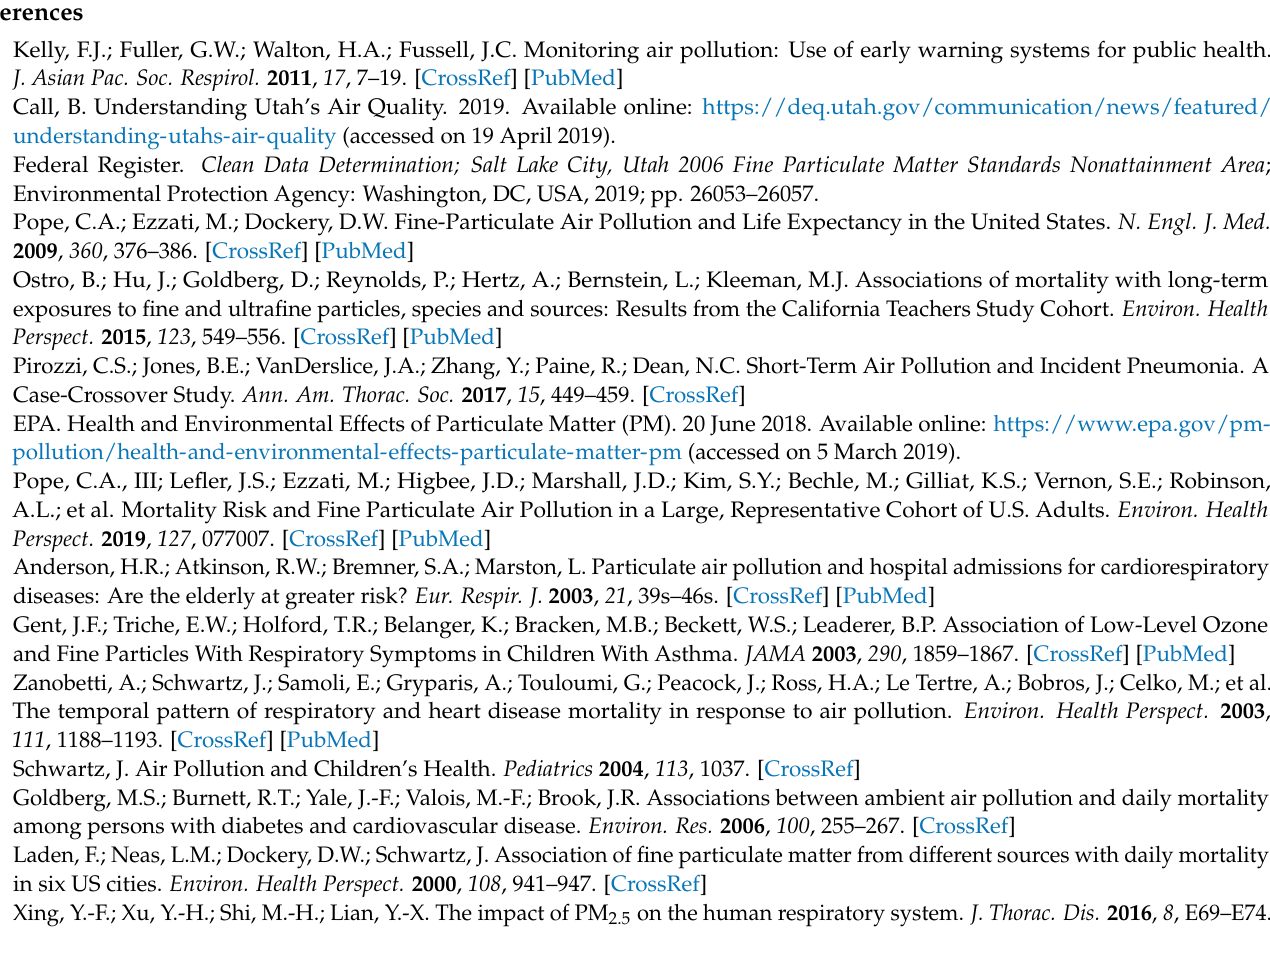
(in µ g/m 3 ) to daily Grimm measurements, showing each linear regression line and its associated R 2 . Figure S2. Changes in AirU/Grimm calibration elements over the study period for (a) AirU124, (b) AirU 125, and (c) AirU